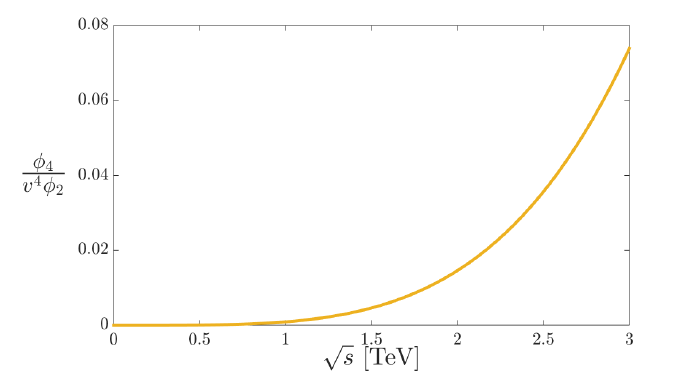
Figure 4: Ratio between the massless four-particle and two-particle phase spaces